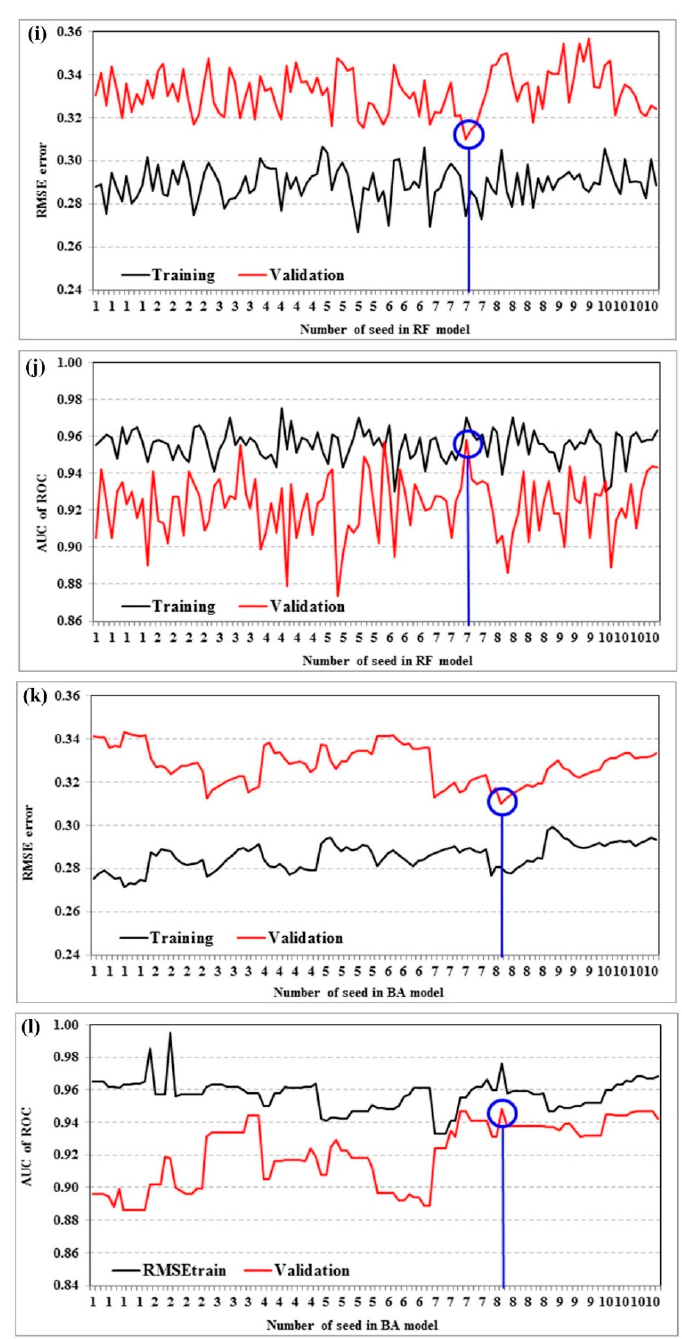
Figure 4. Graphical display of optimal parameters for different numbers of iterations and seeds in the modeling phase (training dataset, panels a-f) and the validation phase (validation dataset, panels g-l). ( a ) Random Subspace (RS) model based on number of iterations and root mean square error (RMSE) ( b ) RS model based on number of iterations and area under the receiver operatic characteristic curve (AUC). ( c ) Random Forest (RF) model based on number of iterations and RMSE. ( d ) RF model based on number of iterations and AUC. ( e ) Bootstrap Aggregating (BA) model based on number of iterations and RMSE. ( f ) BA model based on number of iterations and AUC. ( g ) RS model based on number of seeds and RMSE. ( h ) RS model based on number of seeds and AUC. ( i ) RF model based on number of seeds and RMSE. ( j ) RF model based on number of seeds and AUC. ( k ) BA model based on number of seeds and RMSE. ( l ) BA model based on number of seeds and